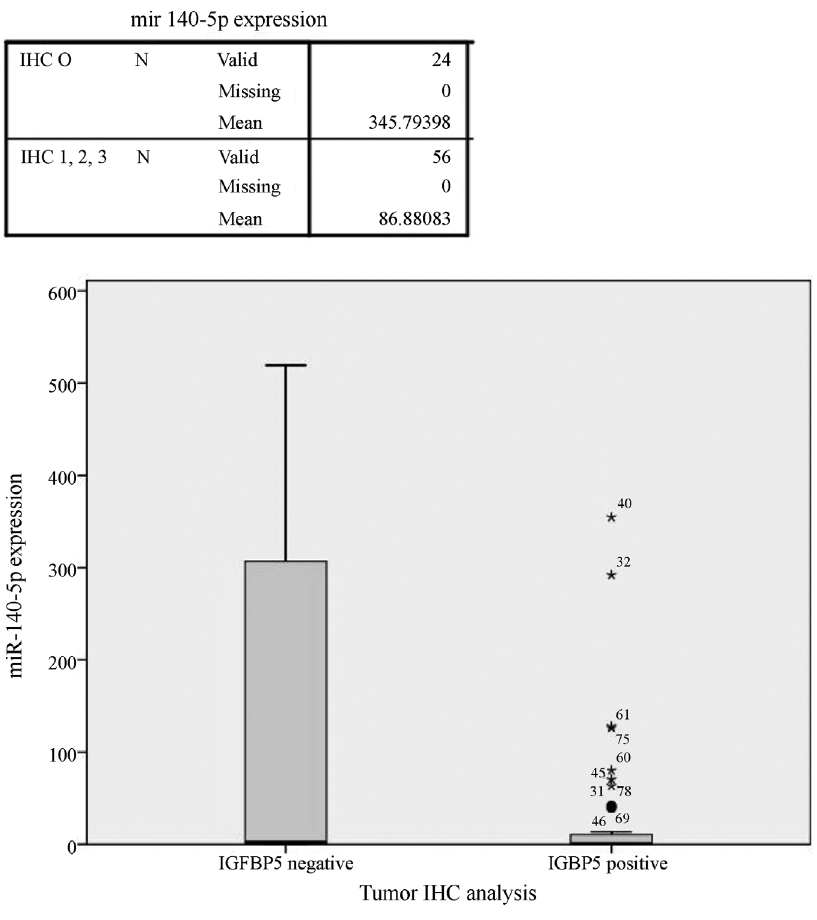
Figure 3 - miR-140-5p expression in tissues with positive and negative immunohistochemical staining for IGFBP5. Of the 80 samples analyzed immunohistochemically, those that were IGFBP5-negative showed significantly greater miR-140-5p expression than IGFBP5-positive samples (p = 0.009; Mann-Whitney U-test); miR-140 expression is 4-fold less than in tissues that do not express IGFBP5 protein. The numbers beside some of the as- terisks (*) states the sample number. The error bars indicate the 95% confidence intervals (CI).